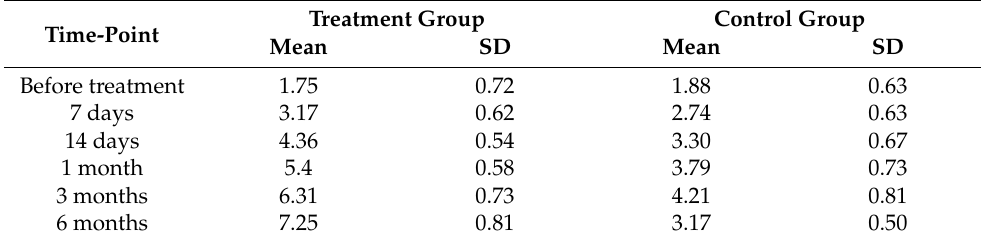
Table 2. Pulp tester measurements in the two groups. Treatment Group Control Group Time-Point Mean SD Mean SD Before